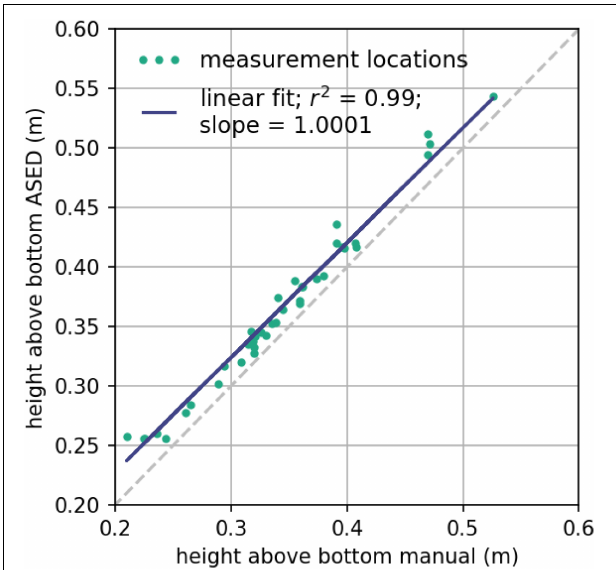
FIGURE 3 | Comparison of height above bed measured by the A-SED and manually measured height above bed of the A-SED, every time the A-SED is installed and retrieved from the field at all measurement stations at the Marconi salt marsh. Green dots show the data, the blue line represents a linear fit of the data (the gray dashed line represents a perfect 1:1 correlation).